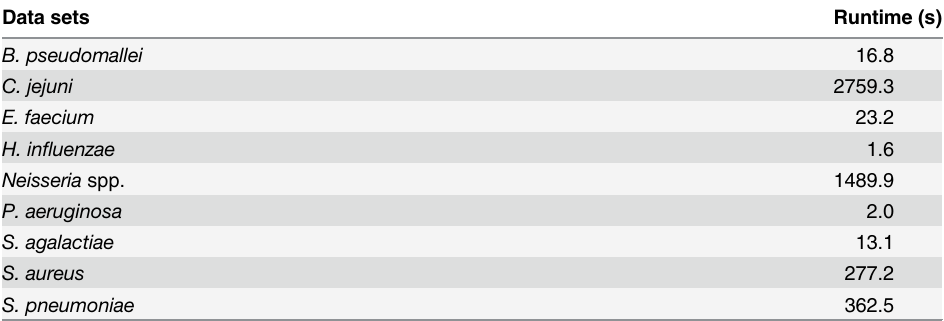
Table 4. Time to compute the number of MSTs in all CCs with STs linked at SLV level. Time presented in seconds, using an Intel i7 a 2.3GHz, with 6GB of RAM. Data